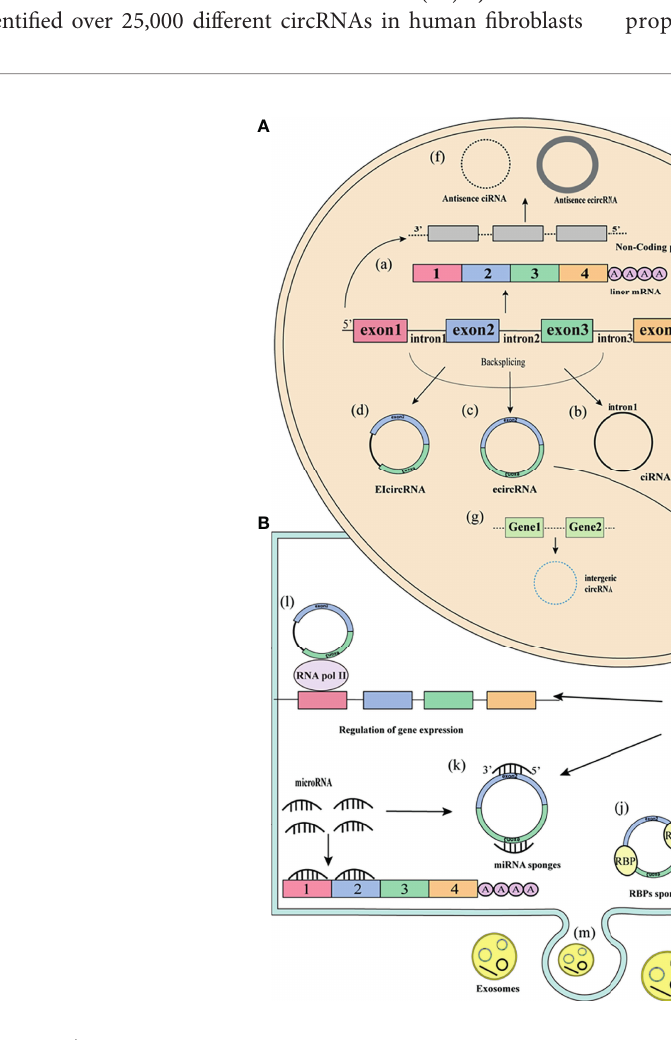
FIGURE 1 | Biogenesis and function of circRNAs (A) Biogenesis of circRNAs. (a) Pre-mRNA splicing removes introns to form mature linear mRNA. (b) The introns removed by pre-mRNA splicing form circularization to form a stable ciRNA. (c) Circularization of pre-mRNA exons into ecircRNA. (d) pre-mRNA exons and introns are circularized into ecircRNAs. (e) removal of pre-tRNA introns, release to form triRNA and tRNA. (f) form antisense circRNAs from non-coding regions of pre-mRNA. (g) from two different intergenic sequences to form intergenic circRNAs. (B) Functions and of circRNAs. (h) circRNAs translation protein with similar IRES sequence. (i) circRNAs as protein scaffolds. (j) circRNAs bind to RBPs. (k) circRNAs as sponges for miRNA. (l) circRNAs interact with RNA polymerase II to regulate gene expression. (m) circRNAs are packaged into vesicles and released outside the cell to perform biological